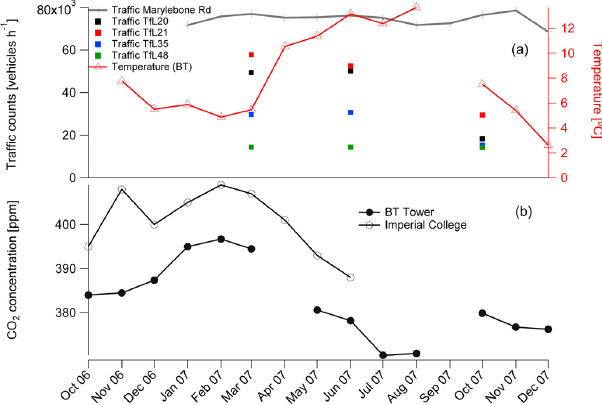
Fig. 5. (a) Traffic counts at Marylebone Road and four Transport for London (TfL) census sites, and temperature measured at the BT Tower in 2007; (b) comparison of mean monthly CO 2 concentra- tions measured at the BT Tower and a tower site at Imperial Col- lege London (at 87m) (Fig. S1, Supplement) (Rigby et al., 2008). BT Tower data for April and September 2007 were excluded since the temporal data coverage was less than 10%.